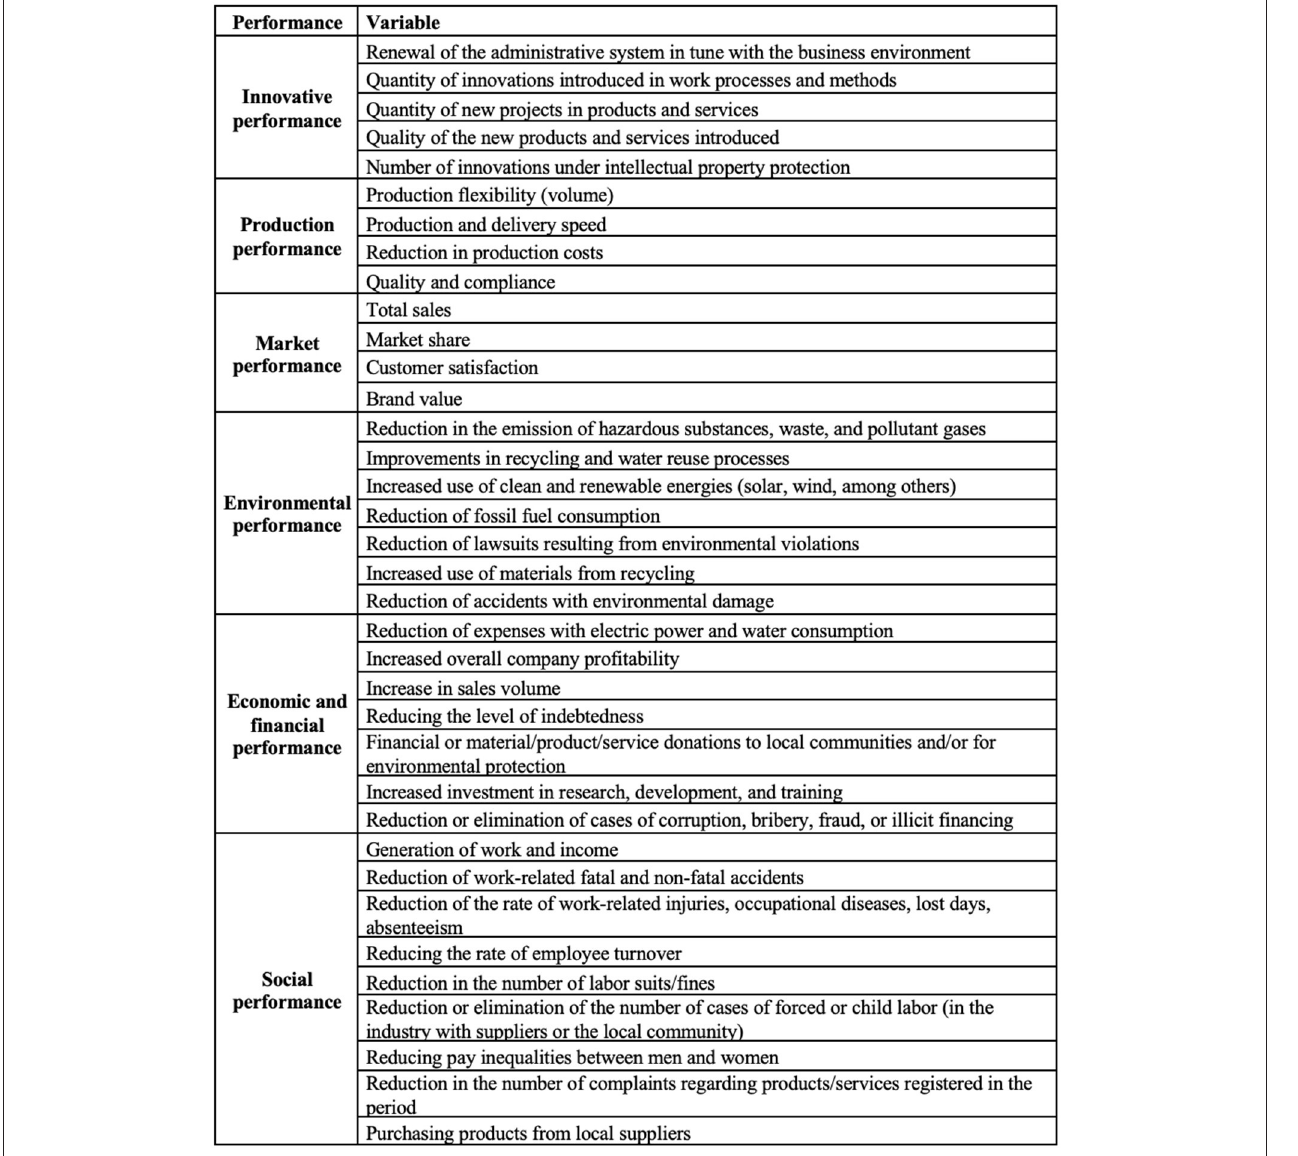
Frontiers in Sustainability |